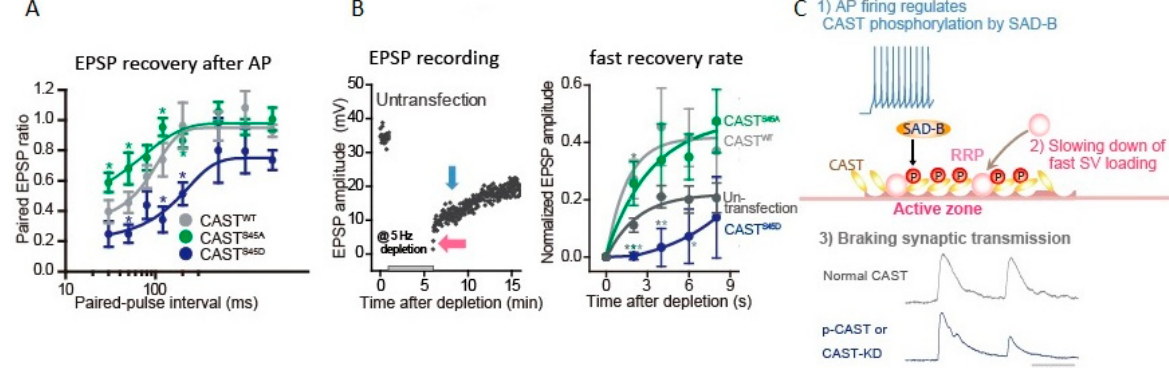
Figure 3. Active zone protein CAST plays a role in synaptic vesicle loading. The presynaptic neurons were transfected with CAST S45 DNA, 2 days before EPSP recording. ( A ) Phosphonegative-CAST S45A relieved the second EPSP reduction, while phosphomimetic-CAST S45D potentiated the reduction. Paired EPSP ratio was plotted against paired-AP interval. (Bar: SEM. * p < 0.05; unpaired student’s t -test. *green, CAST S45A vs. CAST WT ; * navy, CAST S45D vs. CAST WT ) ( B ) EPSP recovery from depletion of SVs. A 5-min train of APs at 5 Hz was applied, as indicated, for SV depletion. EPSP amplitude recovered with two different rates: fast (pink arrow) and slow phases (blue arrow) (left). The fast recovery rate is estimated by an exponential fit to the increase in EPSP amplitude from 0 to 8 s after the depletion (right). (* p < 0.05, ** p < 0.01, *** p < 0.001.; unpaired student’s t -test. *dark gray, CAST S45D or CAST WT vs. un-transfection; *green, CAST S45D vs. CAST S45A ; *gray, CAST S45D vs. CAST WT ) ( C ) Cascaded reactions of CAST phosphorylation. Adapted from Mochida et al., 2016 [56].